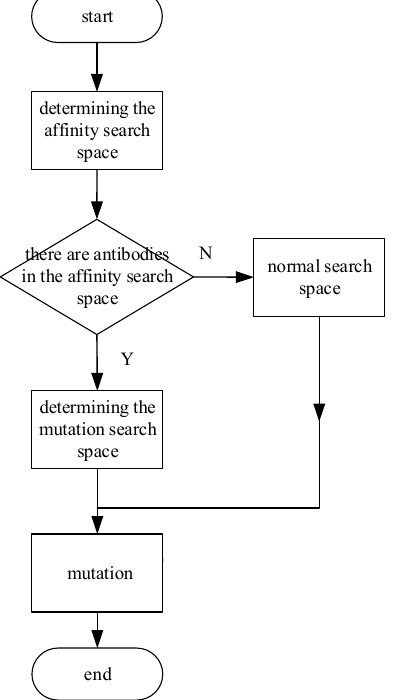
Figure 5. Flowchart of mutation operator d.